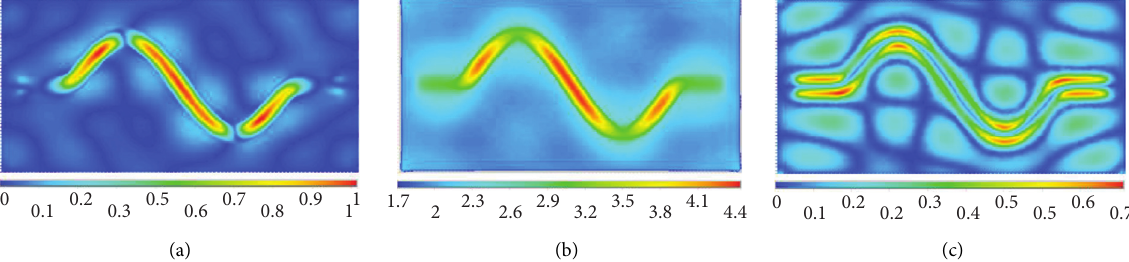
Figure 37: SH wave incident ( H � 150m, f � 1.0Hz, C